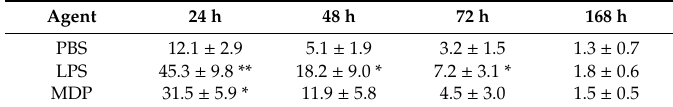
intramammary application of phosphate-bu ff ered saline (PBS), lipopolysaccharide (LPS), and muramyl dipeptide (MDP).